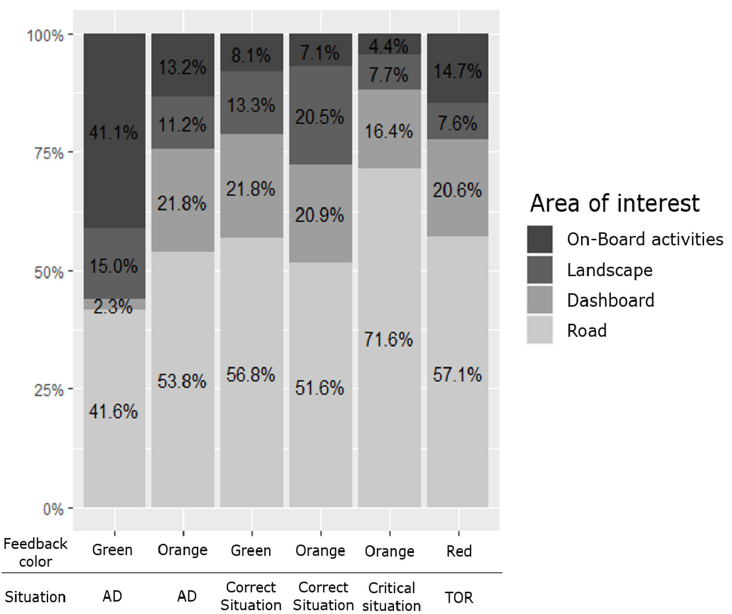
Figure 6. Proportion of drivers’ gazes towards different area of interest. ***: p < 0.001; *: p < 0.05. Table 5. Chi-squared results for the several comparisons.